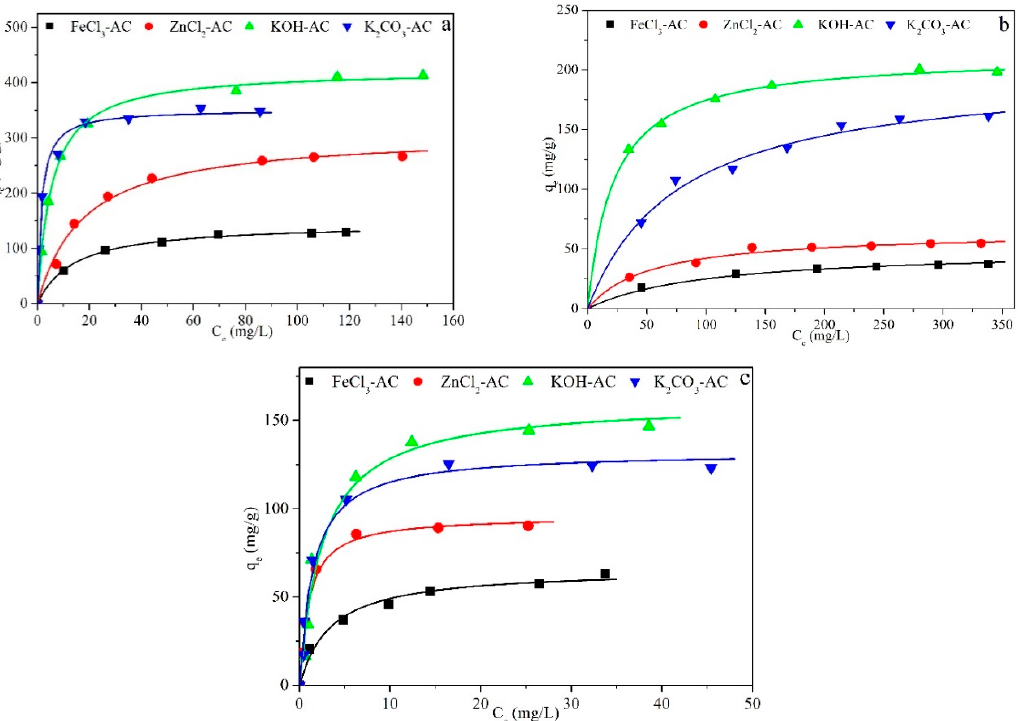
Figure 5. Adsorption isotherms at 20 °C for sulfamethoxazole ( a ), antipyrine ( b ), and desipramine ( c ) on the chemically activated carbons FeCl 3 -AC, ZnCl 2 -AC, KOH-AC and K 2 CO 3 -AC. Symbols: experimental values. Lines: fitting to the Langmuir equation.